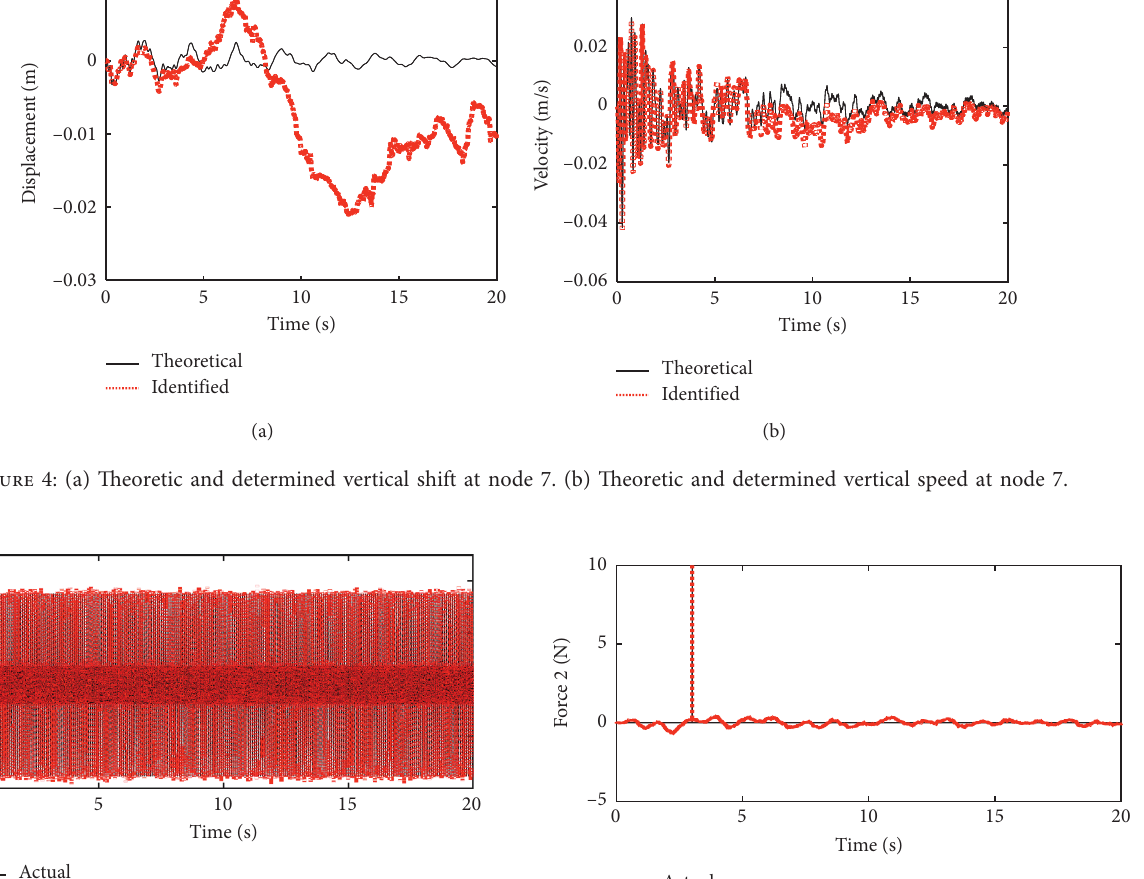
2 through dummy